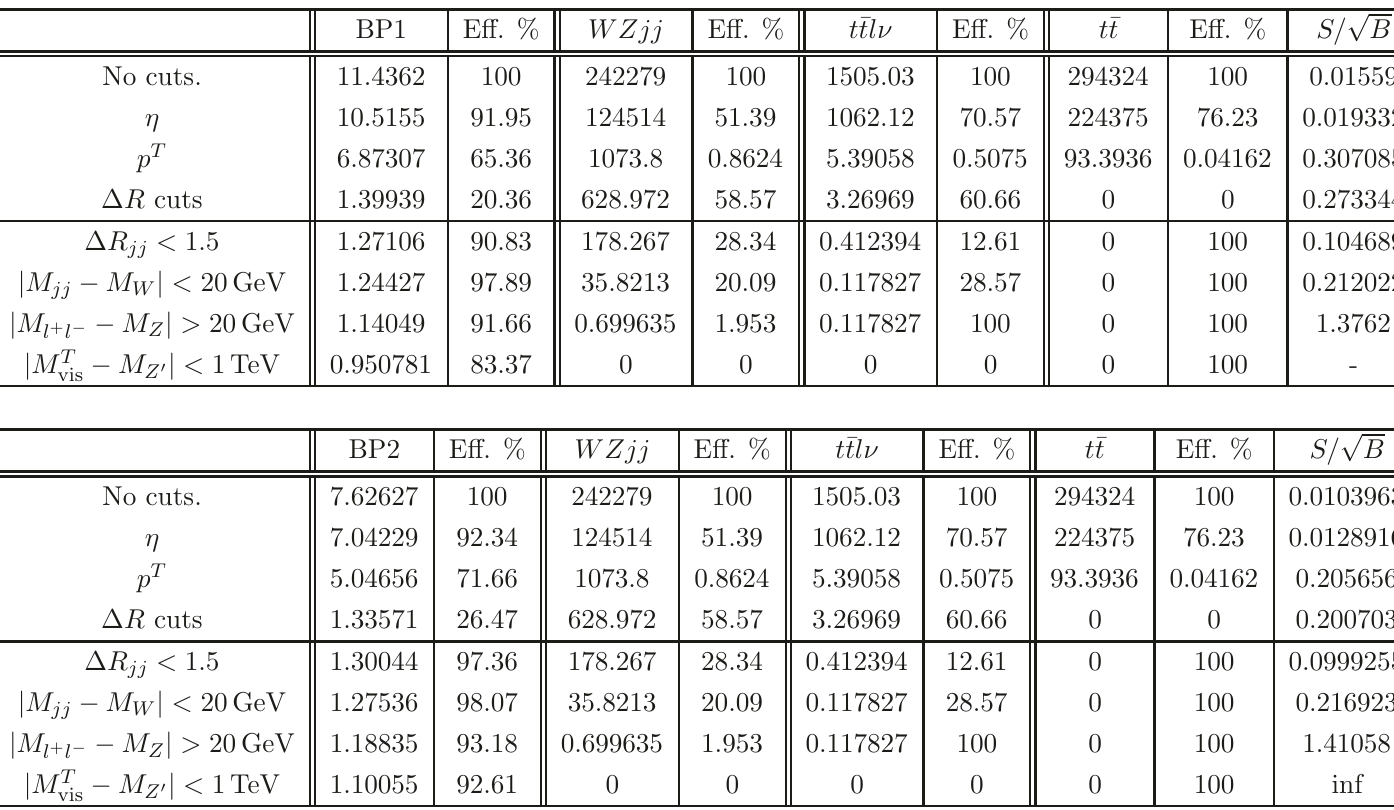
= 300 fb − 1 . Universal acceptance cuts = L